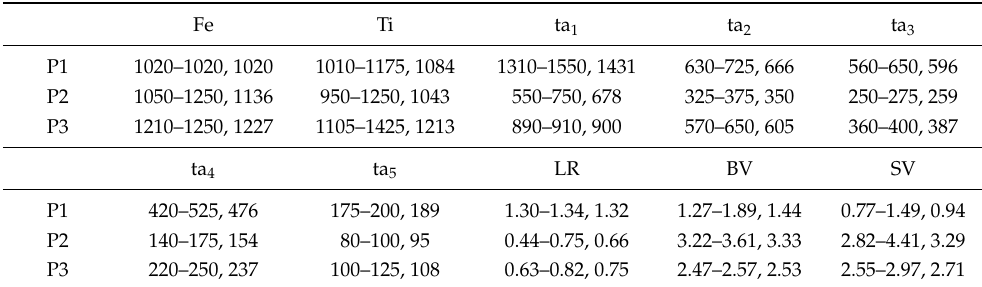
Legs (Figure 13B,C): Fore leg: Distal half of fore femur with 16–20, 18 proximally directed setae in two rows, the longest setae about 160–190, 175 µ m long. width at apex of tibia 77–95, 82 µ m. Mid leg: width at apex of tibia 75–80, 76 µ m, tibia with one apical spur 40–50, 44 µ m long. Hind leg: tibia 75–82, 80 µ m width at apex; tibia with one spur 40–48, 44 µ m long. Lengths (in µ m) and proportions of legs in Table 6. Table 6. Male adults of Microtendipes wuyiensis sp. nov. Length (in µ m) and proportions of leg ( n = 4). Fe Ti ta